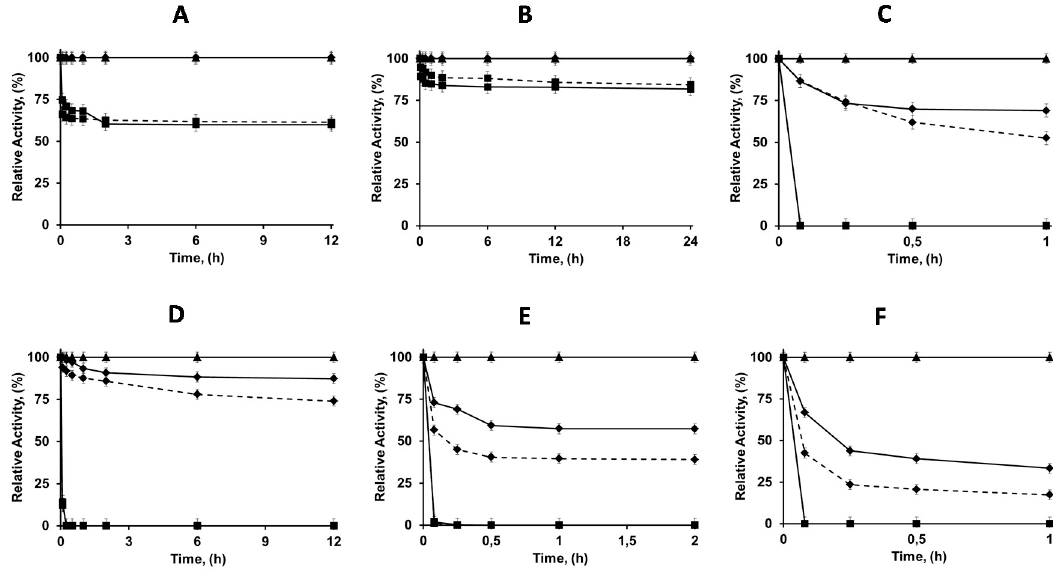
Figure 2. Immobilization courses of different lipases on amino agarose supports, EDA (solid black line) and HDA (dashed line). Immobilizations were performed in 5 mM buffer sodium phosphate at pH 7 and 25 °C. Other specifications are described in Section 2. ( A ) CALA, ( B ) CALB, ( C ) CRL, ( D ) RML, ( E ) TLL and ( F ) LU. Rhombus (suspension), square (Supernatant), triangle (Soluble enzyme).